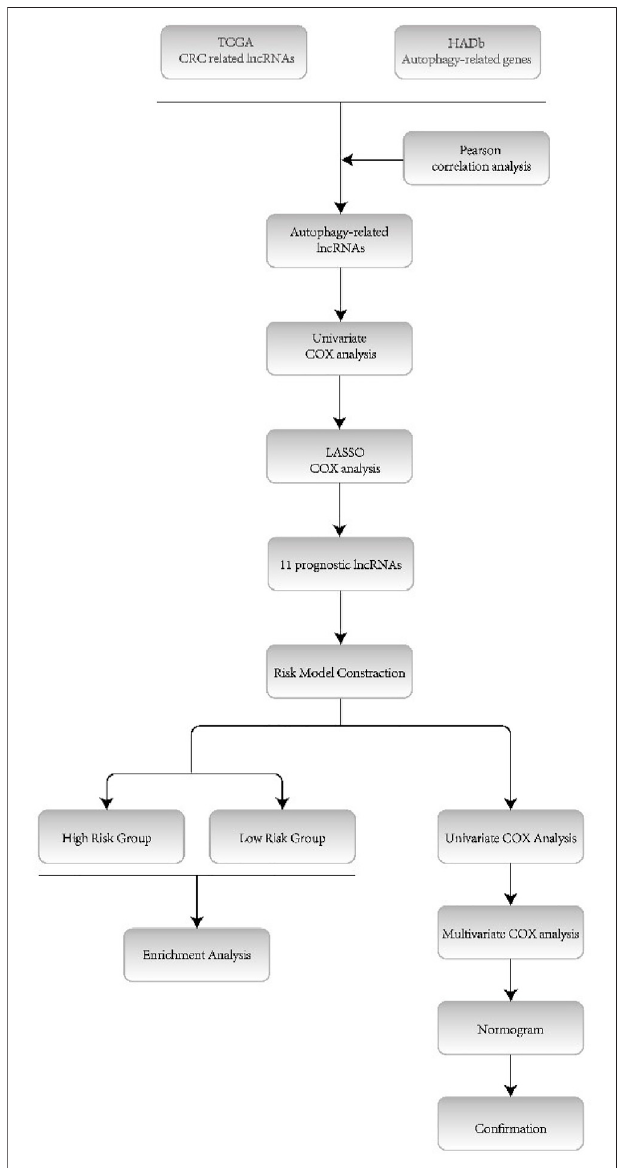
FIGURE 1 | Flow diagram of this